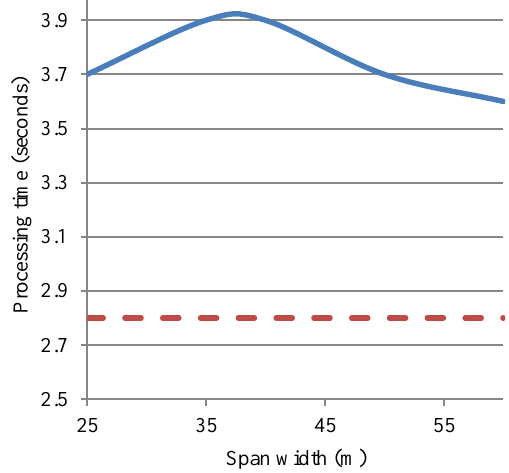
Figure 5 Span width versus processing time. The solid line show the processing times for segmentation with varying span width. The dotted line shows the processing time for a static segmentation.